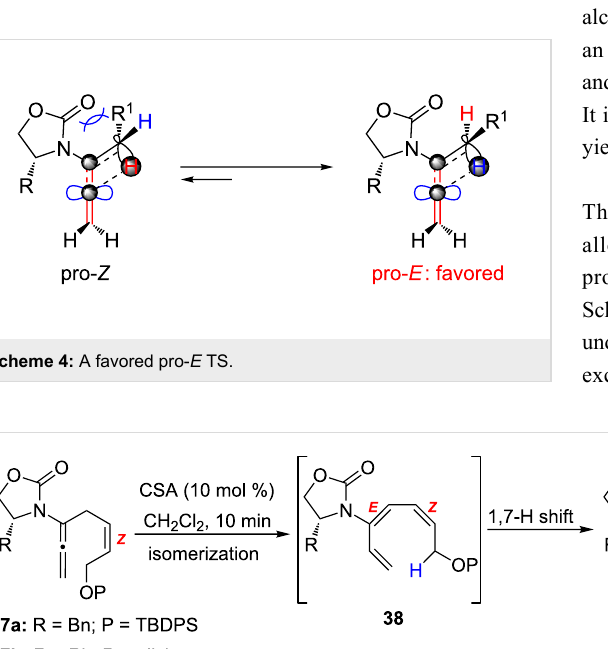
radical pathway, the observed E -selectivity in the thermal 1,3- hydrogen shift should be favoured because the pro- Z transition state experiences a greater allylic strain compared to the pro- E transition state (Scheme 4). A thermodynamically driven equili- bration from ( Z )- to ( E )-enamide post-isomerization is a real possibility that cannot be ruled out, and the observed solvent effect on the ( E / Z )-selectivity would particularly support this possible notion.